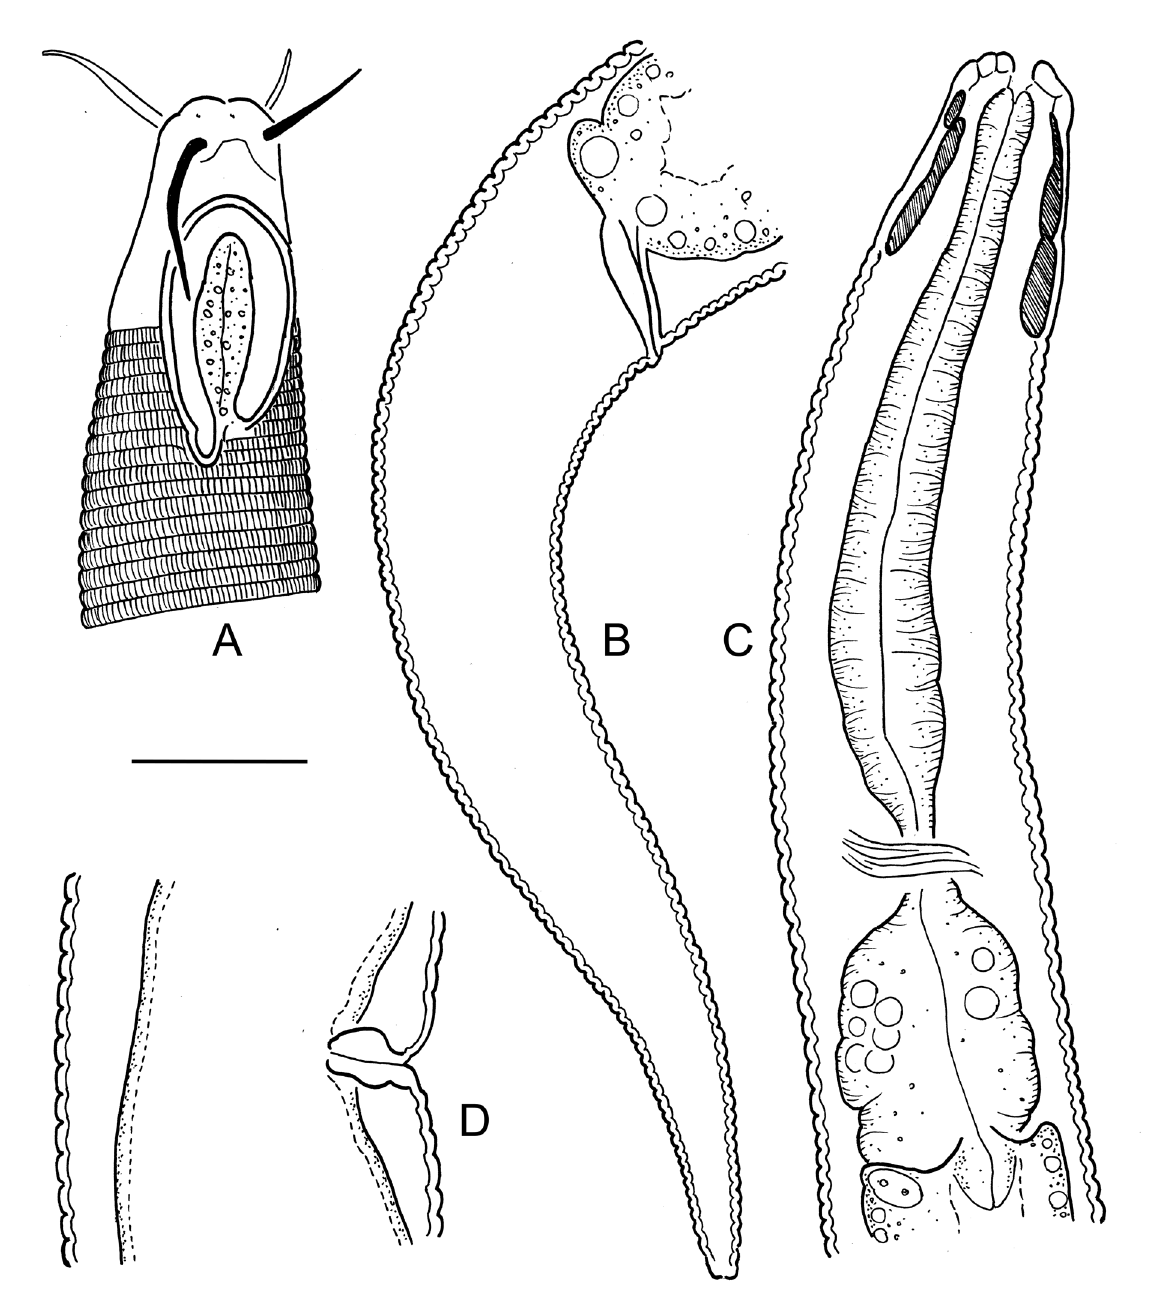
Fig. 10. Diplopeltoides grandis sp. nov. A . Female anterior end, surface view. B . Female tail. C . Female pharyngeal region, optical median section. D . Vulval region. Scale bar = 20